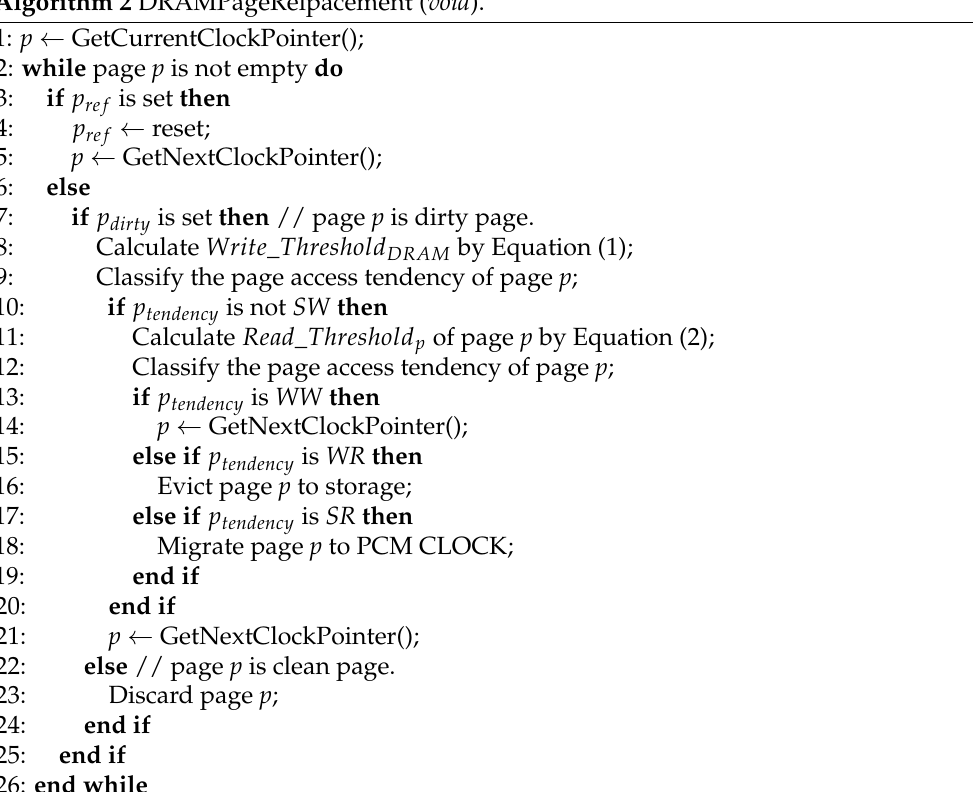
Algorithm 2 DRAMPageRelpacement ( void